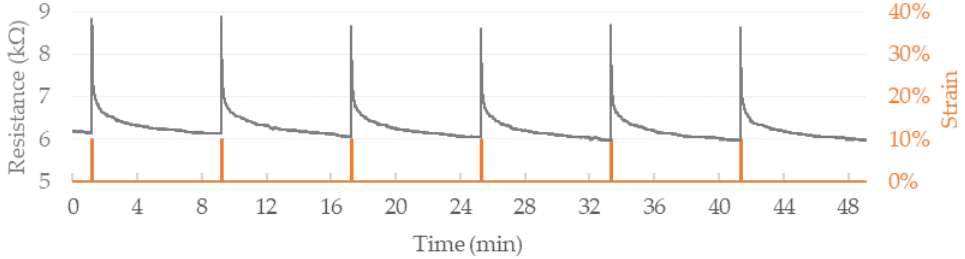
return to the starting position at an equal pace. Multiple initial strains exhibited signifi-